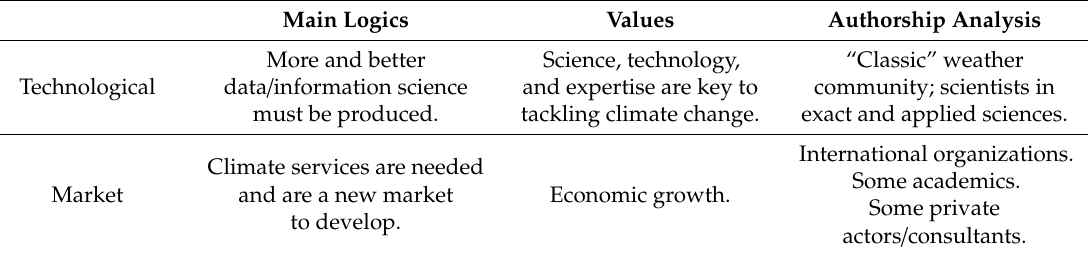
Table 1. Framing climate services in the